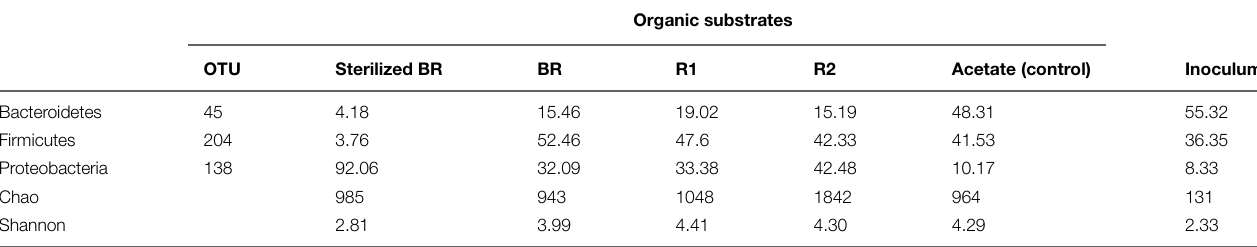
TABLE 2 | Bacterial diversity at the phylum level in the microcosms prepared from the immature shale (7 m depth).